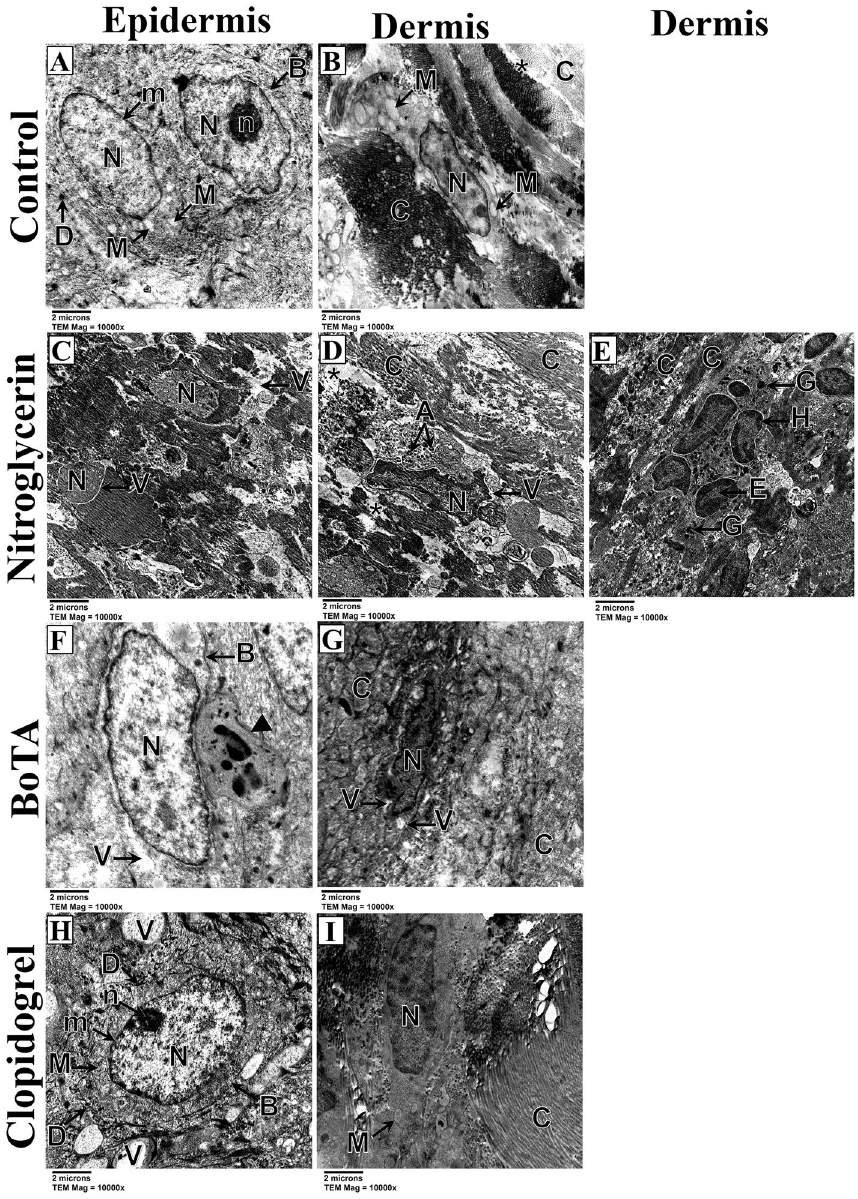
Figure 6. Electron micrographs of skin flaps of the induced flap ischemia subgroups; control ( A,B ), nitroglycerin ( C–E ), BoTA ( F,G ) and clopidogrel ( H,I ) subgroups. ( A ) The epidermis shows keratinocytes with euchromatic irregular nuclei (N), distinct nuclear membranes (m) and a distinct nucleolus (n) in one of them. The mitochondria are swollen with absent cristae (M). The cell boundaries (B) are distinct showing apparent desmosomes (D). (TEM; × 10,000—Scale bar = 2 µm). ( B ) The dermis shows a fibroblast with a relatively regular euchromatic nucleus (N) and edematous mitochondria with lost cristae (M). The collagen fibers are relatively regular and arranged in horizontal and vertical manners (C), however, there are areas of their absence (asterisk). (TEM; × 10,000—Scale bar = 2 µm). ( C ) The epidermis shows keratinocytes with massively degenerated nuclei that have homogenous euchromatin all over (N) and absent nuclear membranes. The cytoplasm shows loss of its organelles and massive vacuolations especially around the nuclei (V). The intercellular boundaries are mostly lost. (TEM; × 10,000—Scale bar = 2 µm). ( D ) The dermis shows a fibroblast with an irregular nucleus demonstrating peripheral chromatin condensation (N) and perinuclear vacuolation (V), and cytoplasmic apoptotic bodies (A). Note the presence of areas of highly packed collagen fibers (C), in addition to areas of their absence (asterisk). (TEM; × 10,000— Scale bar = 2 µm) € The dermis shows a neutrophil with a lobulated nucleus having marginal heterochromatin (H) and central bright euchromatin (E), and cytoplasmic granules (G). The surrounding collagen fibers show areas of condensation (C). (TEM; × 10,000— Scale bar = 2 µm). ( F ) The epidermis shows a keratinocyte having an euchromatic irregular nucleus (N). The cytoplasm is with lost organelles and cytoplasmic vacuolations (V). The cell boundaries are distinct (B), however, the desmosomes are absent. Note the presence of a neutrophil (arrowhead) beside the keratinocyte with a lobulated nucleus and cytoplasmic granules. (TEM; × 10,000— Scale bar = 2 µm). ( G ) The dermis shows a fibroblast with irregular cytoplasmic vacuolations (V) and irregular nucleus having peripheral chromatin condensation (N). Note the presence of highly irregular collagen fibers (C). (TEM; × 10,000—Scale bar = 2 µm). ( H ) The epidermis shows a keratinocyte with a regular oval nucleus (N), distinct nucleolus (n) and nuclear membrane (m), and normally appearing mitochondria with distinct cristae (M). The cell boundary (B) is highly distinct with well-developed desmosomes (D). Note the presence of extracellular vacuolations (V). (TEM; × 10,000—Scale bar = 2 µm). ( I ) The dermis showing a fibroblast with a regular euchromatic nucleus (N) and minimally swollen mitochondria with lost cristae (M). The surrounding collagen fibers are highly regular and parallel (C). (TEM; × 10,000—Scale bar = 2